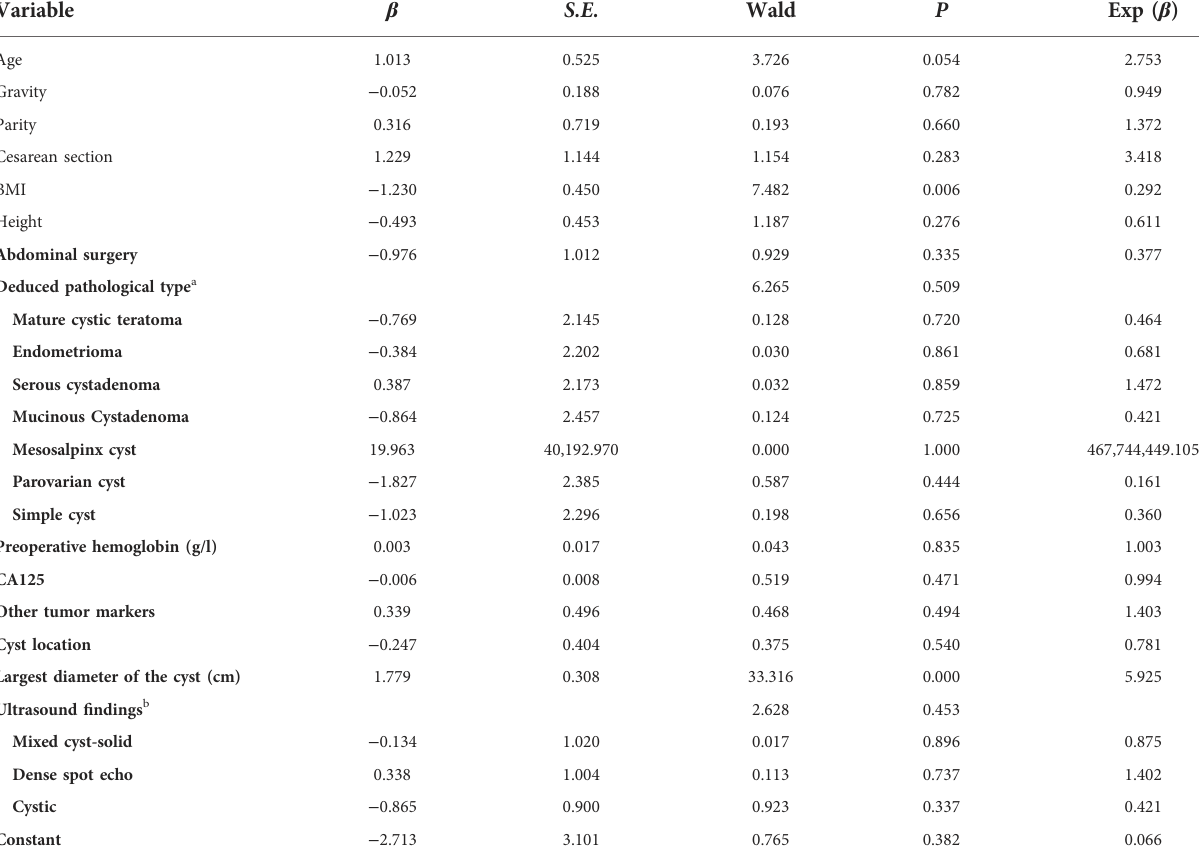
TABLE 2 Multiple logistic regression